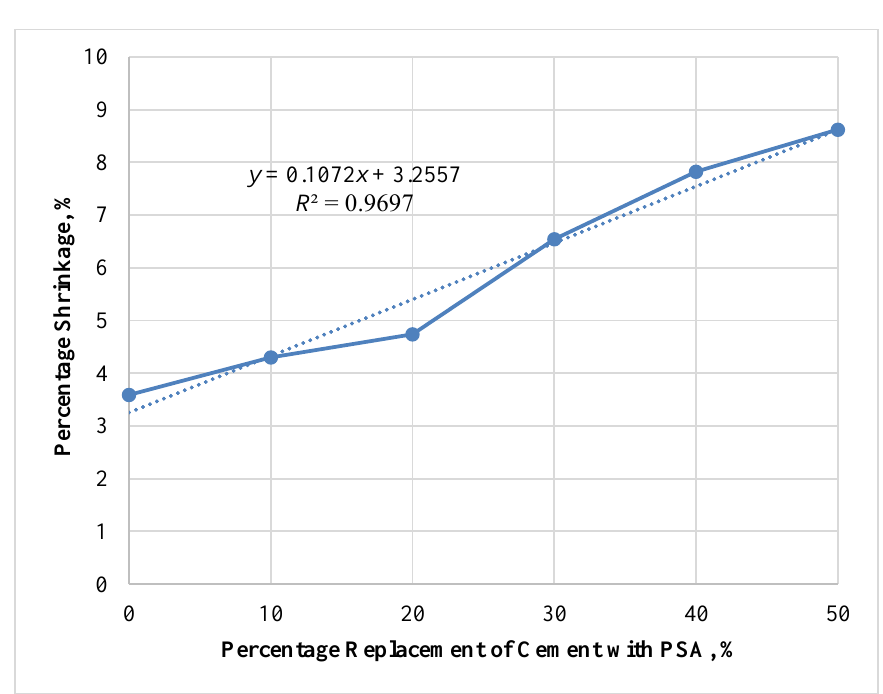
Fig. 3. Regression plot of shrinkage on the 28 th day (developed by the